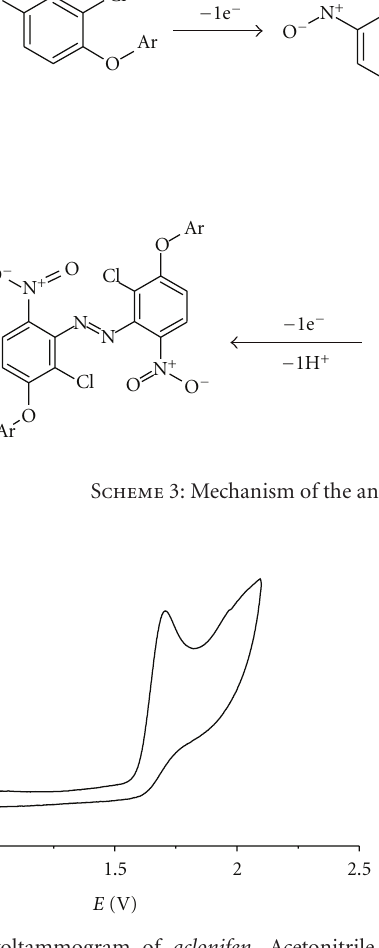
Figure 3: Oxidation voltammogram of aclonifen. Acetonitrile, NBu 4 BF 4 0.1M, C = 3mM, v = 20 mVs − 1 , glassy carbon disk ( d = 3 mm), reference: SCE.